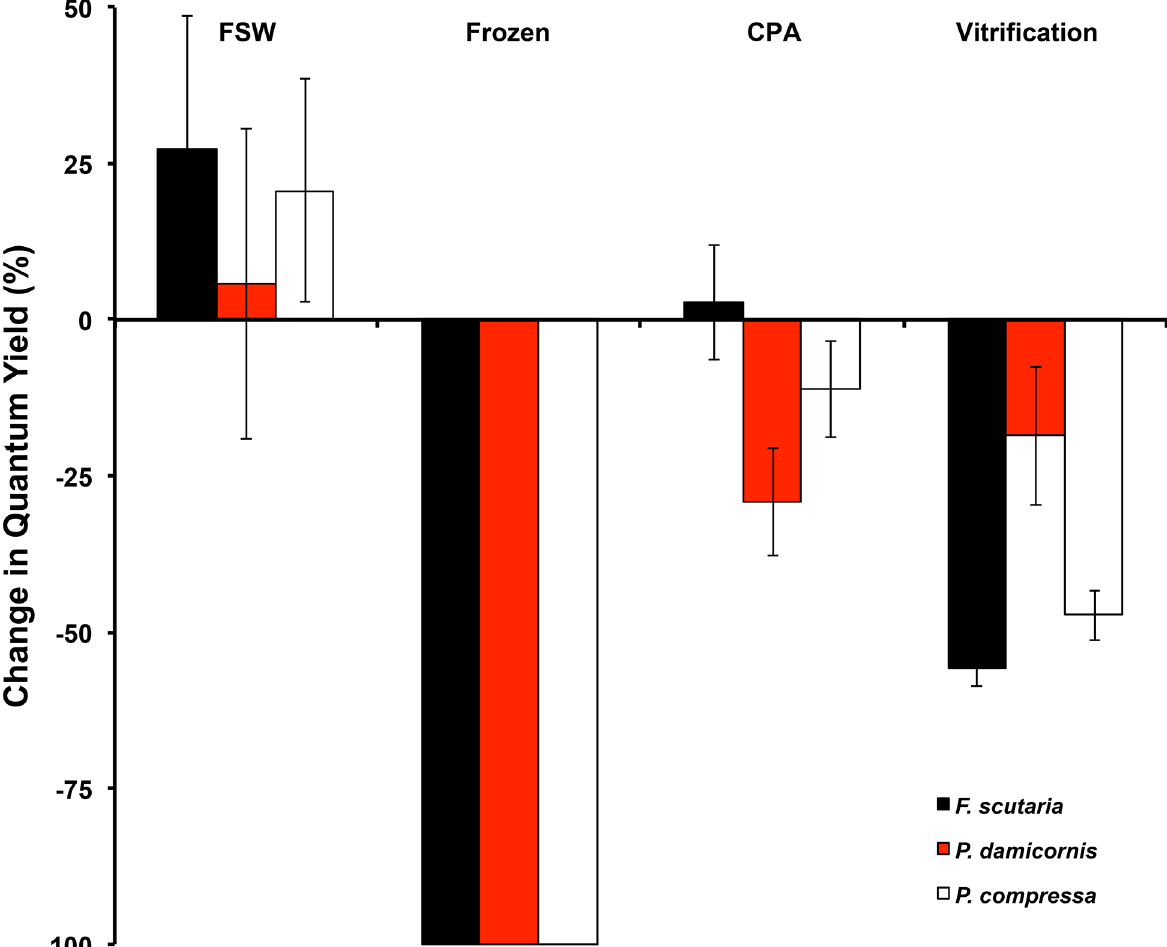
Fig 4. Comparative vitrification results, using the Vitri-3 treatment, for Symbiodinium from three Hawaiian coral species. At least ~50% survival was achieved regardless of source of the symbionts.